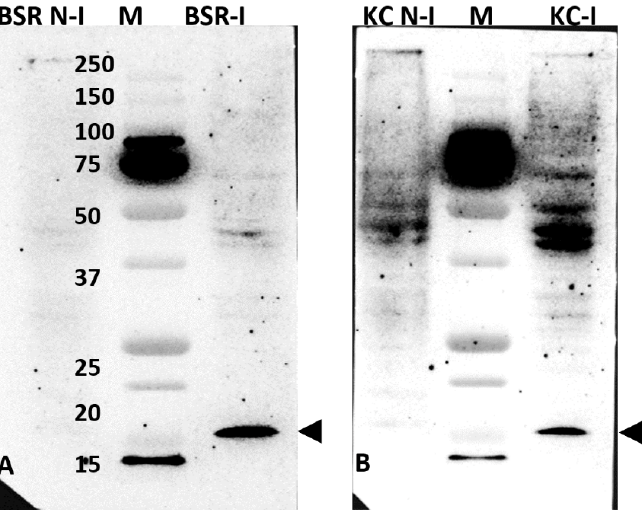
Figure 5. Western blot analysis of BTV-1-infected BSR (left panel) or KC (left panel) cell lysates. Mouse anti-NS5 antiserum was initially adsorbed onto non-infected BSR cells to remove non-specific antibodies. Non-infected and BTV-1-infected BSR ( A ) or KC ( B ) cell lysates were probed using the pre-adsorbed anti-sera, showing a protein band in infected lysates at ~15 KDa (as indicated by the arrowhead). This band was not detected in the non-infected lysates. M = size markers.